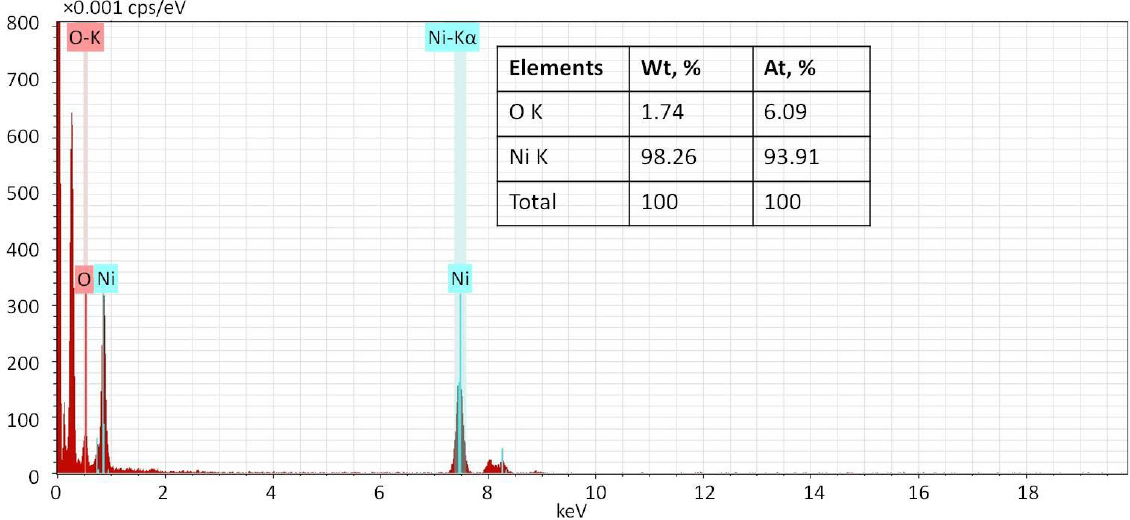
Figure 7. EDX spectrum of Ni NPs@PPP prepared at 280 °C by the heat-up approach.